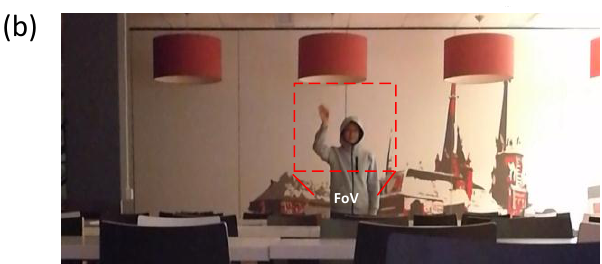
Figure 20. ( a ) Nine consecutive frames were recorded at 6 frames/s with resolution of 64 × 64 at 10 m, where a human subject was waving his right hand and turning around; ( b ) image captured with a commercial camera.